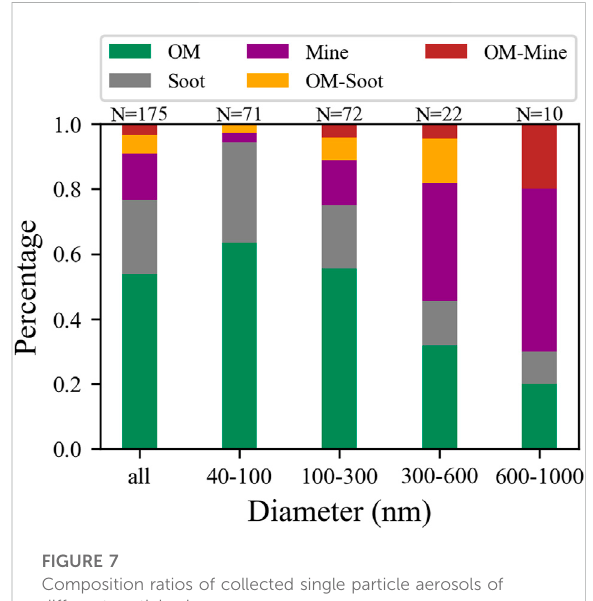
Composition ratios of collected single particle aerosols of different particle sizes.